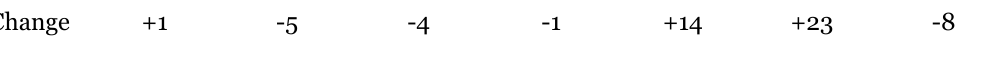
Change in CRT Scores for Teachers Using Open Textbooks 2010–2011